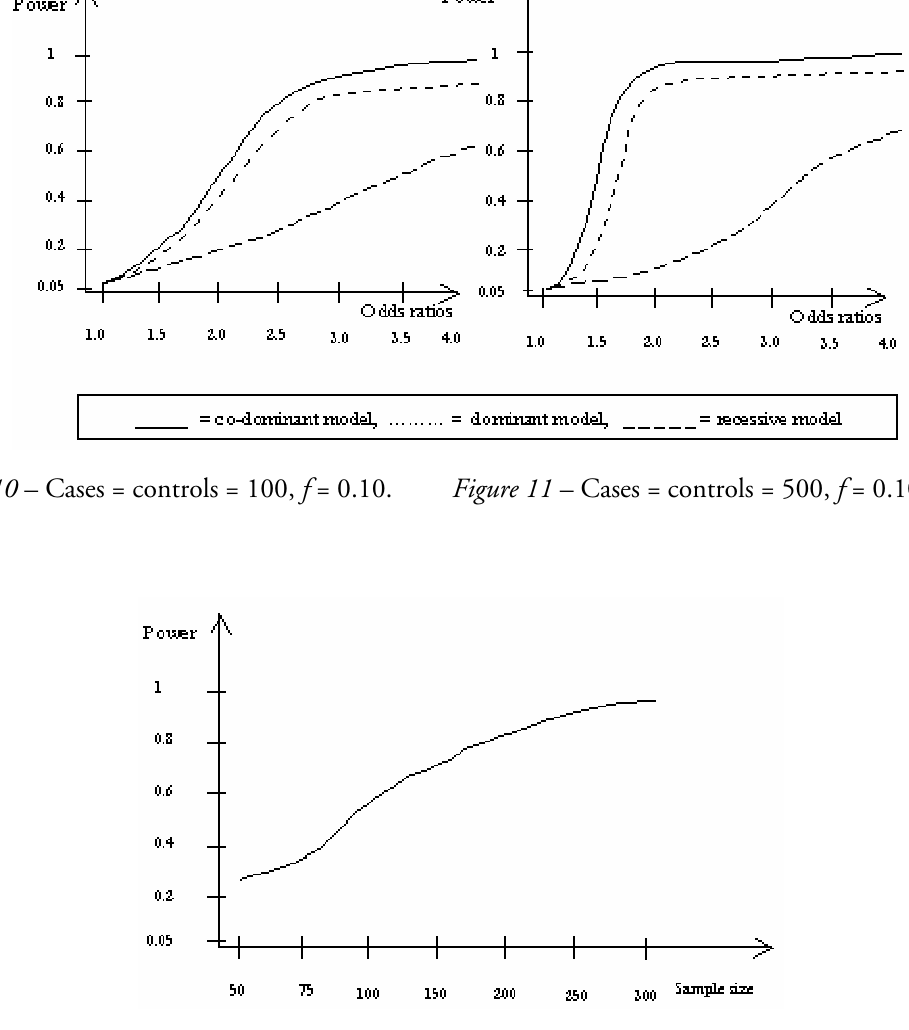
Figure 12 – Co-dominant model with odds ratios = 2, f = 0.10, (cid:118) =